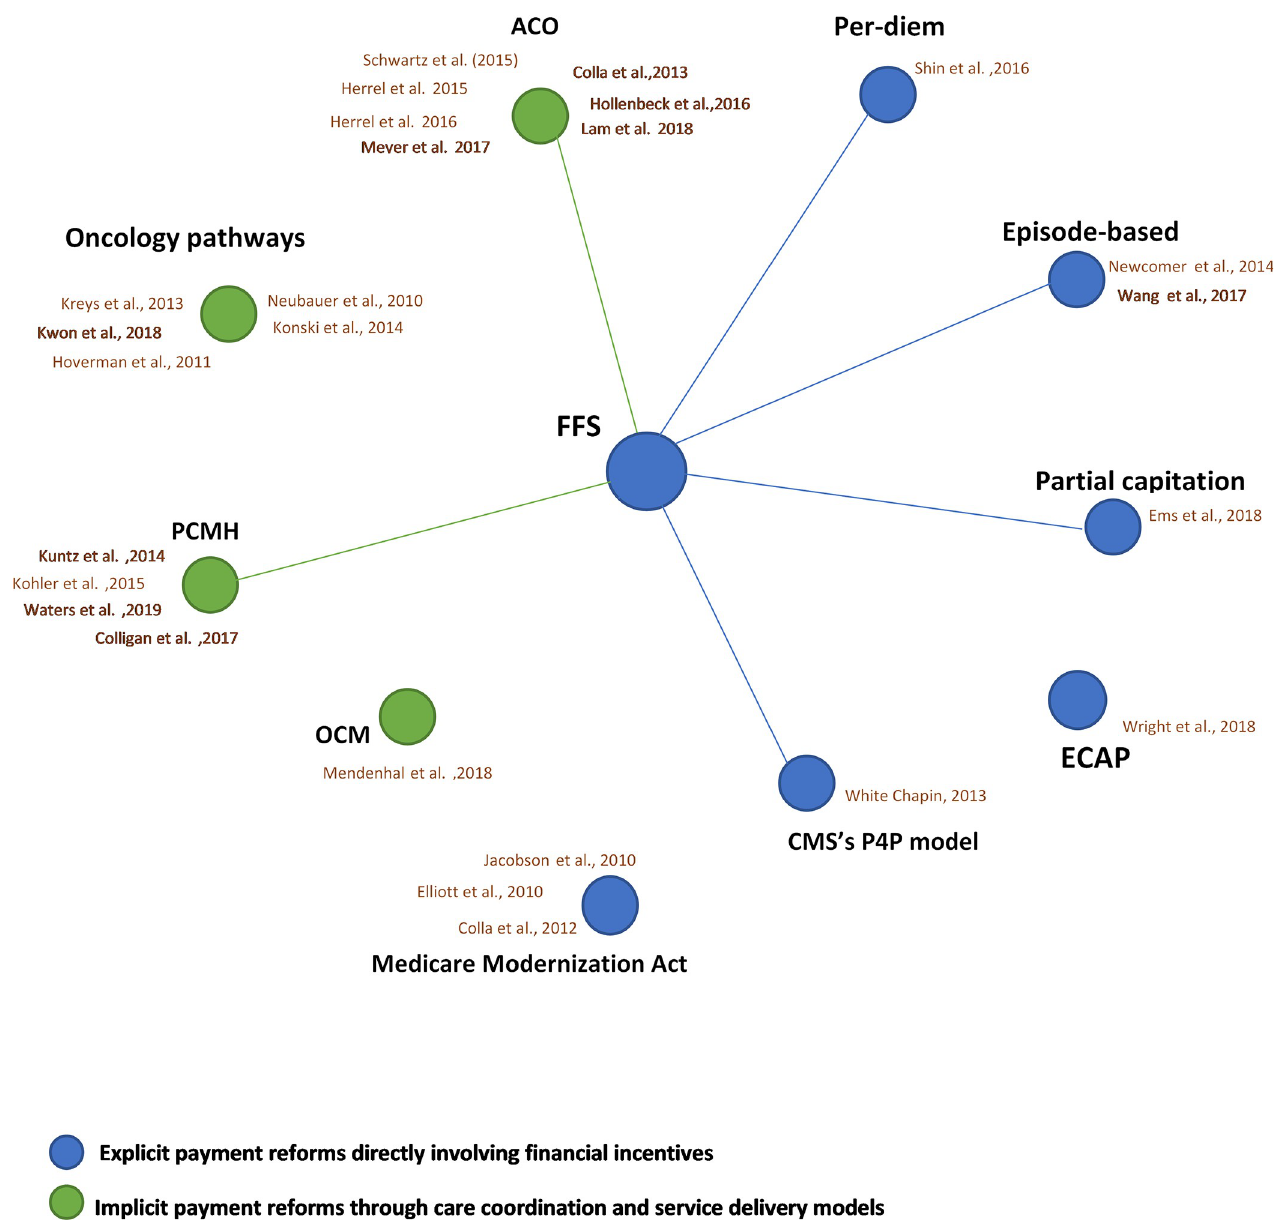
Fig 2. Evidence network for the provider payment reforms in cancer care identified in the SLR. Direct line indicates head-to-head comparison of the interventions as emerged from the data. ACO, accountable care organization; CMS, centers for Medicare and Medicaid services; ECAP, endometrial cancer alternative payment; FFS, fee-for-service; P4P, pay for performance; OCM, oncology care model; PCMH, patient centered medical home.